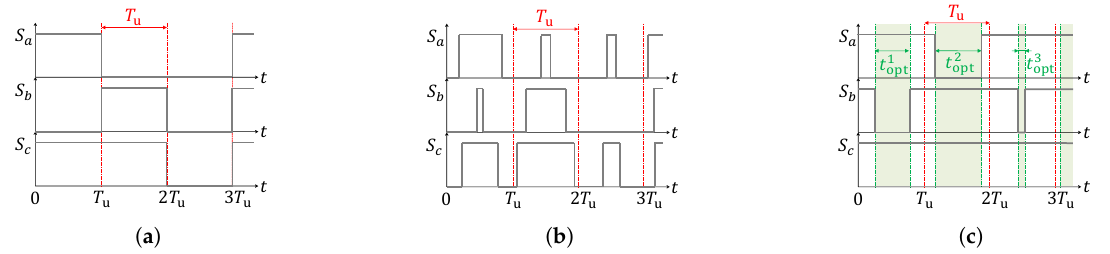
Figure 4. Difference in switching between ( a ) FS-MBPC; ( b ) PI and DB control; ( c ) MBPC with duty cycle calculation.